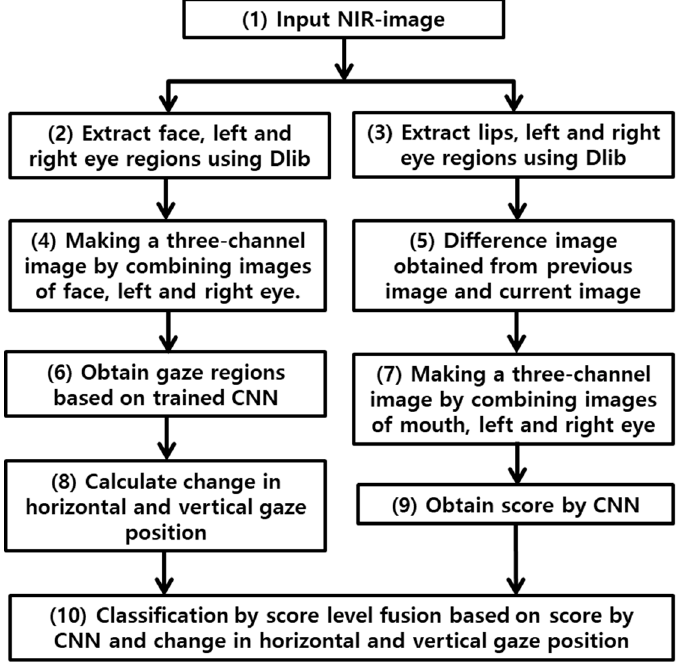
Figure 1 . Flowchart of proposed method. Figure 1. Flowchart of proposed method. Remote Sens. 2020 , 12 , x FOR PEER REVIEW